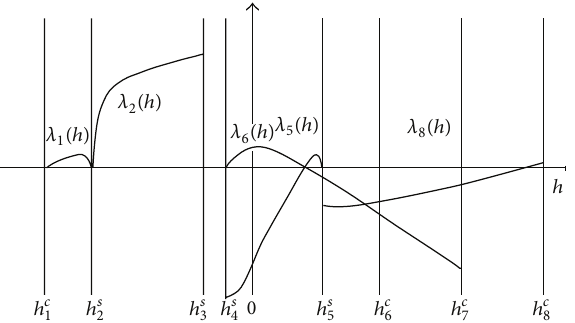
Figure 4: Graphs of detection curves of system ((9a) and (9b)) with parameter conditions UP and PG are given.